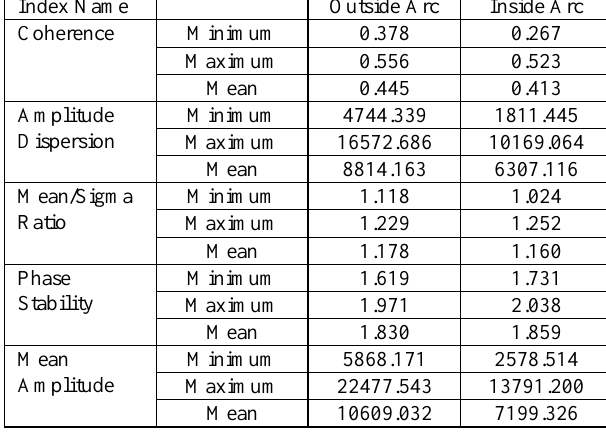
Table 3. Statistic indexes of radar signal in time sequence corresponding to part of two parallel arcs (Note that the amplitude has not been normalized)